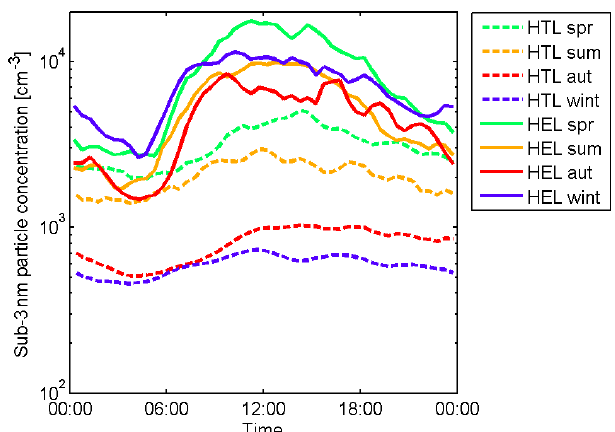
Figure 5. The median diurnal variation in sub-3nm particle con- centration in Hyytiälä (HTL; dashed lines) and in Helsinki (HEL; solid lines) in different seasons: spring (spr), summer (sum), au- tumn (aut), and winter